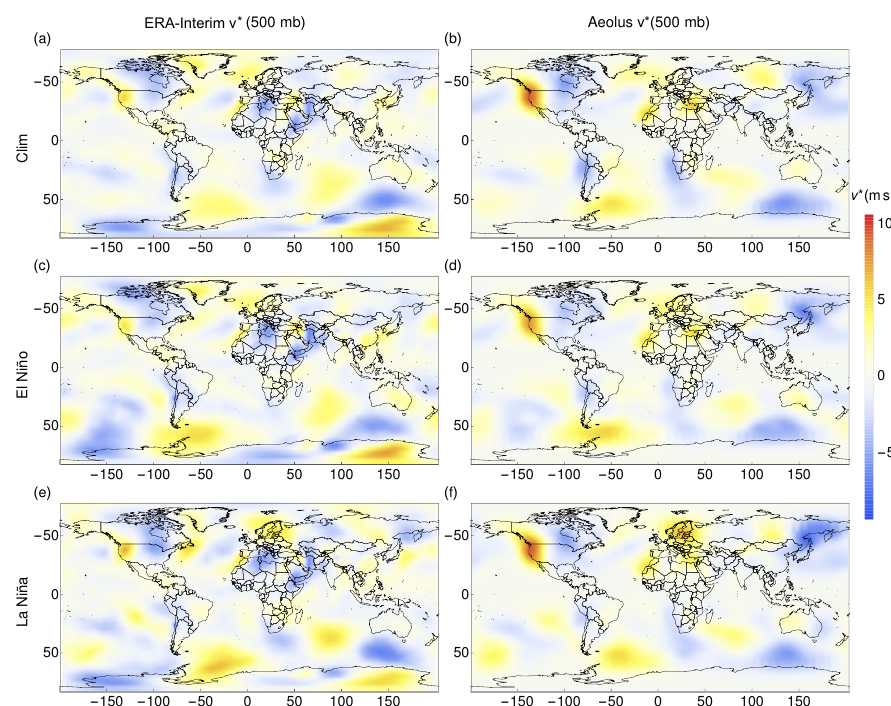
Figure 4. Azonal large-scale meridional wind velocity v ∗ at 500mb for August (compare Fig.